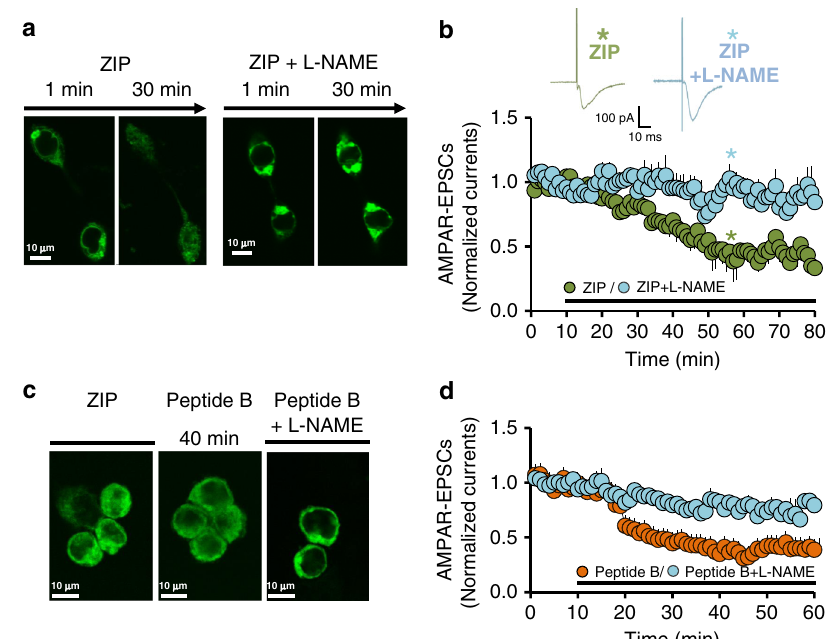
Fig. 4 ZIP-induced GluA1 redistribution in HEK293 cells and AMPAR-EPSCs decrease in the NAc are mediated by NO. a Representative fl uorescent images taken from continuous live monitoring of HEK293 cells expressing GFP-GluA1, at 1 and 30 min after bath application of ZIP (5 µ M), without (left panels, N = 5) or with L-NAME (50 µ M, right panels, N = 5). b AMPAR-EPSCs before and after application of ZIP without (green circles; N = 7, n = 7) or with L-NAME (light blue circles; N = 7 n = 7). Representative EPSC traces taken at the time indicated by the asterisks are shown on the top. Data presented using normalized values± SEM. c Representative fl uorescent images taken from HEK293 cells expressing GFP-GluA1 fi xed after 40 min incubation with ZIP (5 μ M, left; N = 5), Peptide B (5 μ M, middle; N = 6) and Peptide B (5 μ M) + L-NAME (50 μ M, right; N = 5). d AMPAR-EPSCs recorded before and after application of Peptide B in the presence (light blue circles; N = 5, n = 5) or absence of L-NAME (orange circles; N = 5 n = 5). Data presented using normalized values±